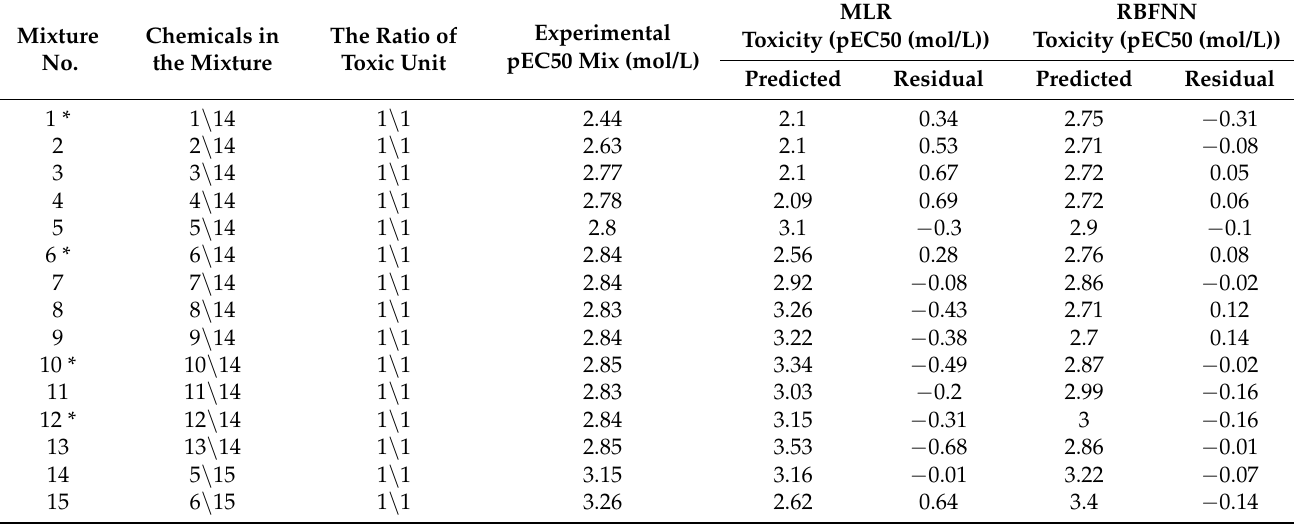
Table 5. The number of chemicals in the mixtures, ratio of toxic unit, experimental pEC50 mix, predicted pEC50 mix, and their corresponding